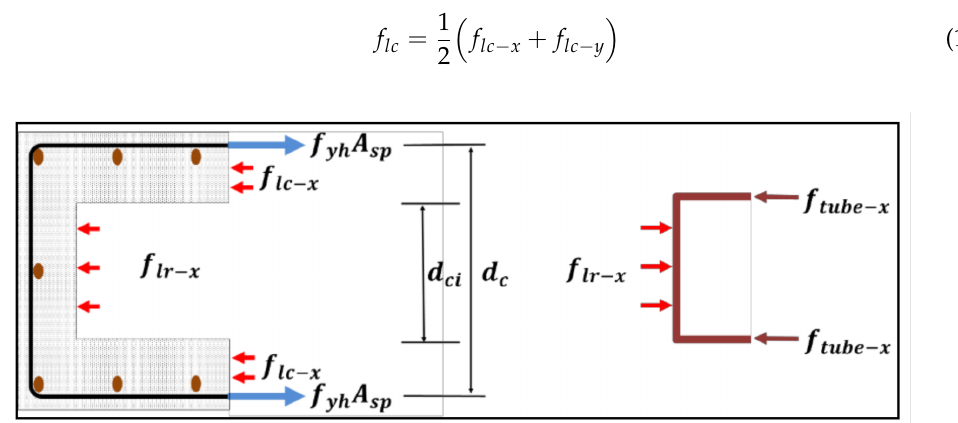
Figure 3. Confining stress on concrete in an ICH RC column in x-direction: ( left ) FBD for concrete and reinforcement; ( right ) FBD for internal tube.